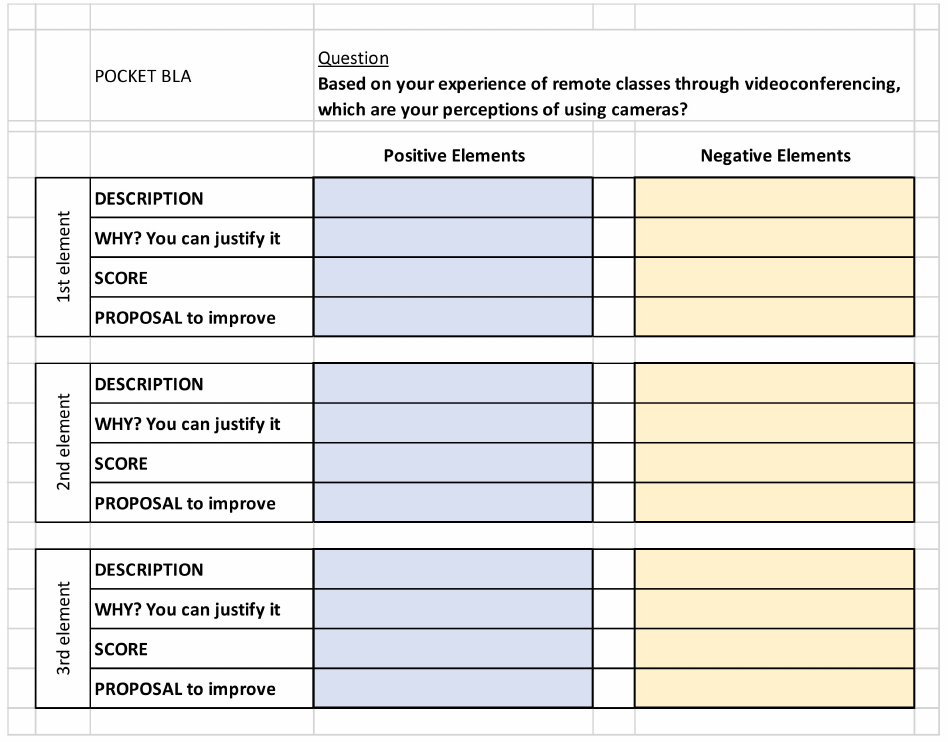
Figure 1. Pocket BLA: Template to be completed by the participants about the use of cameras when